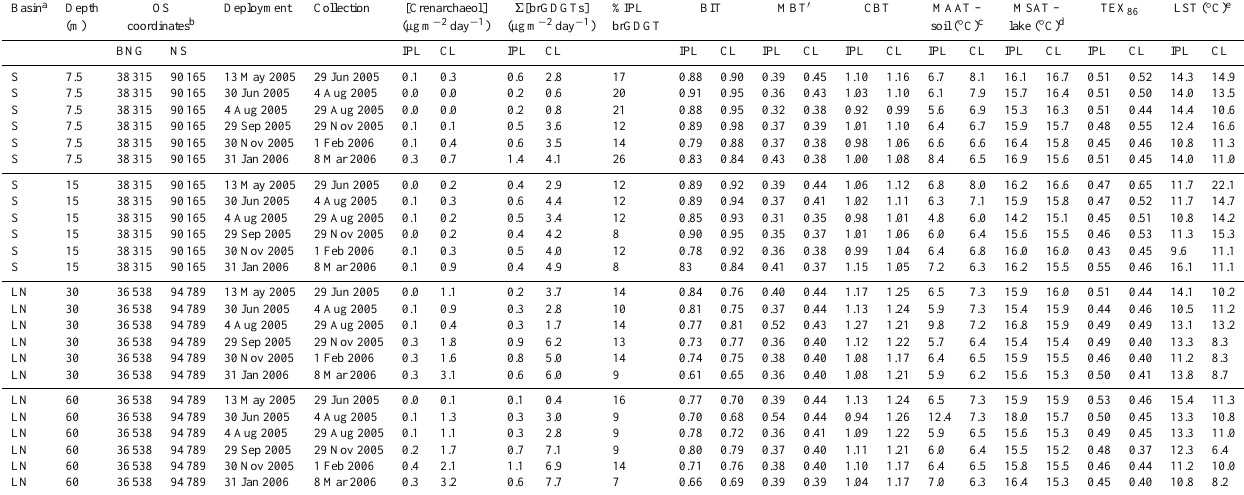
Table 4. Settling particles data from sediment trap deployments from 13 May 2005 to 8 March 2006 from the middle and bottom of the water column: crenarchaeol fluxes and brGDGT fluxes and BIT indices, MBT 0 indices, CBT ratios, TEX 86 indices, inferred mean annual air temperatures (MAATs), inferred mean summer air temperatures (MSATs) and inferred lake surface temperatures (LSTs). Basin a Depth